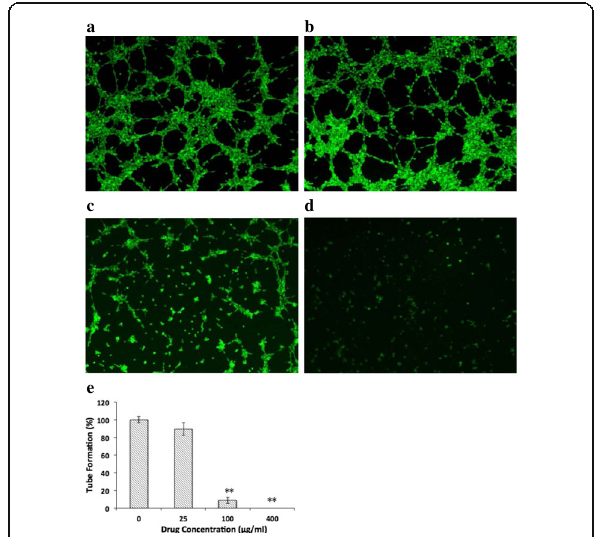
Fig. 5 Effect of oridonin on HUVEC tube formation. HUVECs were treated with various concentrations (25 – 400 μ g/ml) of oridonin. a control group; b 25 μ g/ml oridonin group; c 100 μ g/ml oridonin group; d 400 μ g/ml oridonin group; e tube formation rate comparison.